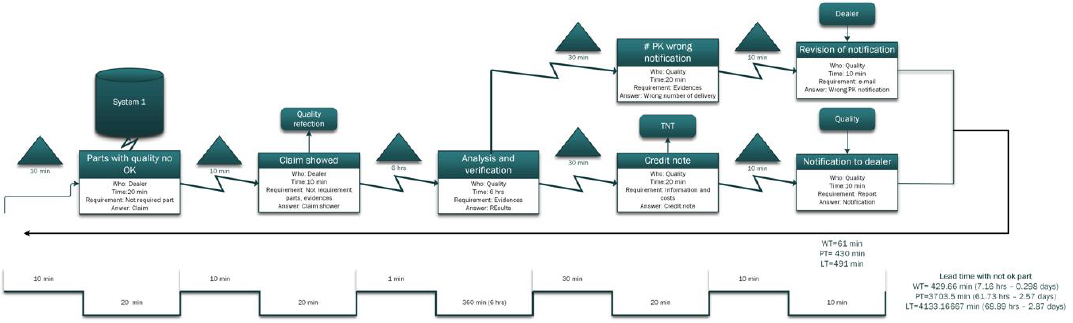
Figure 21. The third part of four of the future state map is displayed.